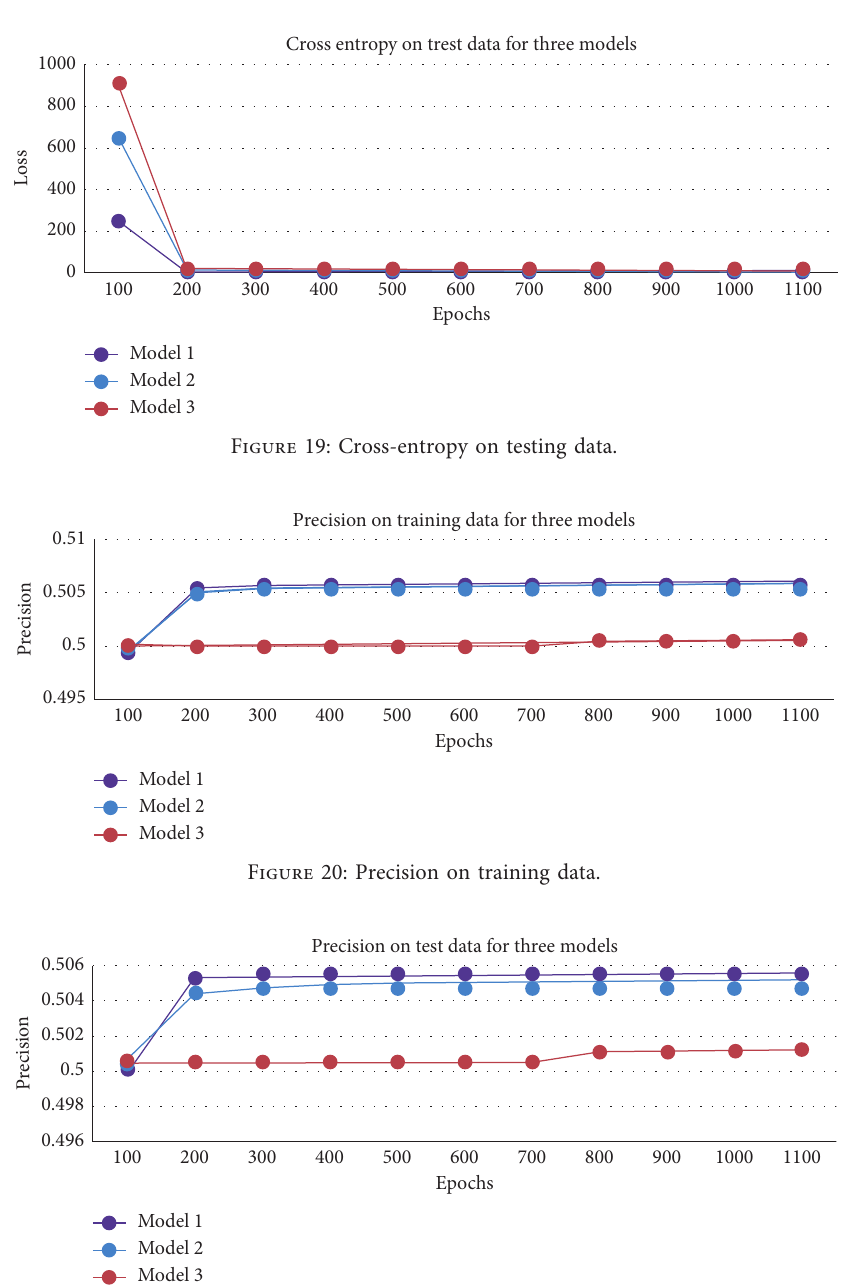
Figure 21: Precision on testing